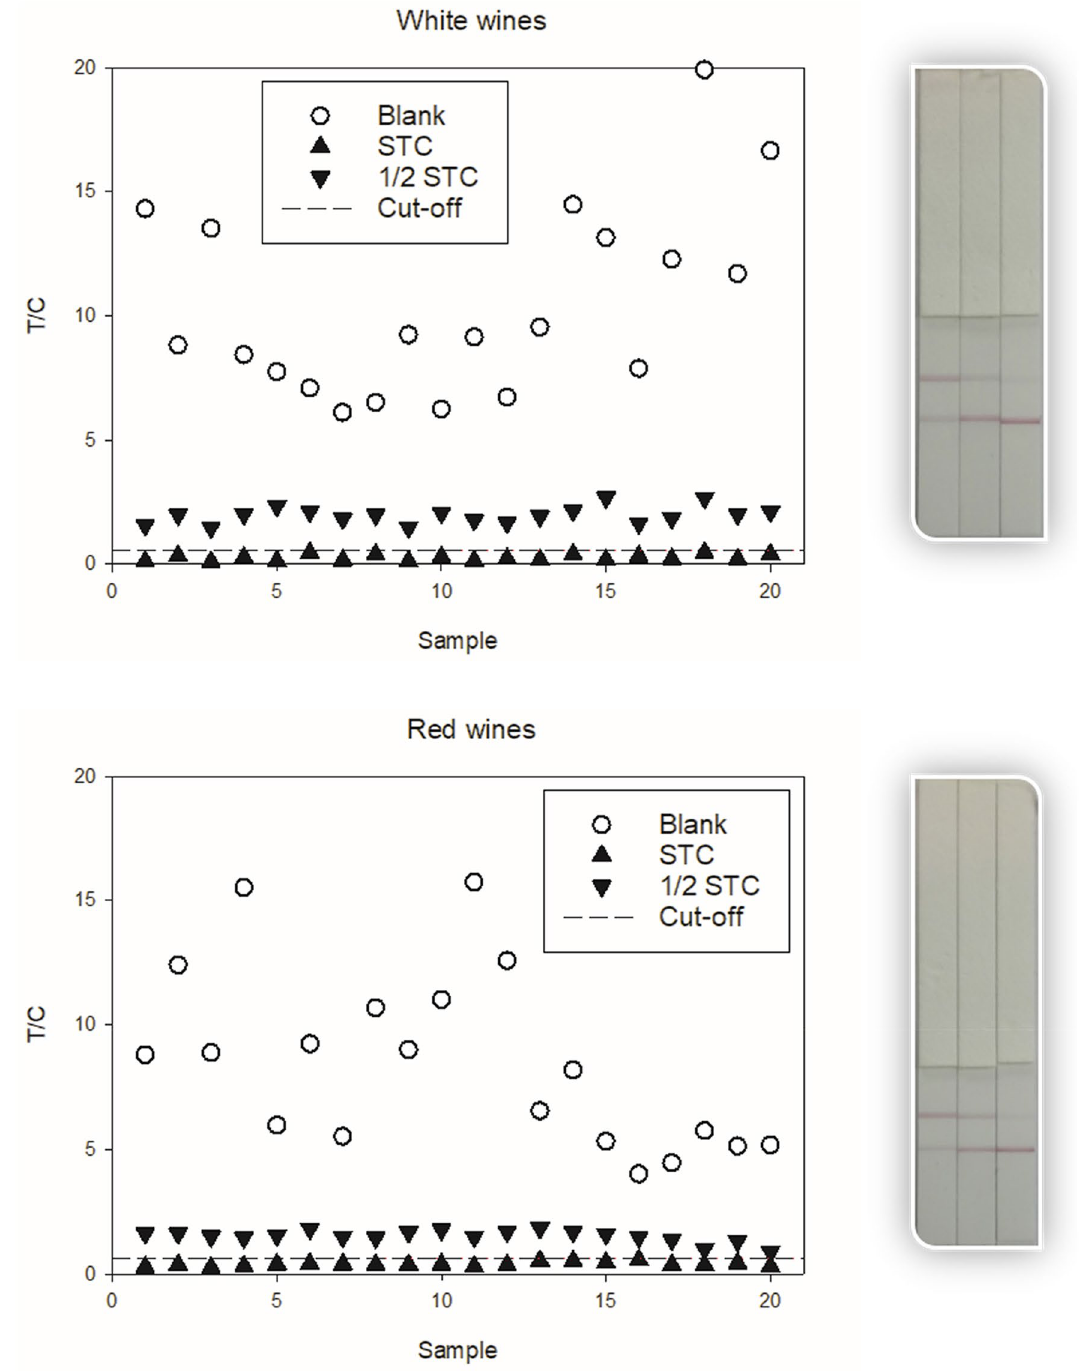
Figure 3. Lateral flow immunoassay response and cut-off values for SP determination in wine samples obtained for blank samples and samples containing SP at STC and 50% STC. The immunostrips show the obtained results for wine samples fortified with SP at (from left to right) 1000, 500, and 0 μg/L, and treated as optimized to hydrolyse SP into